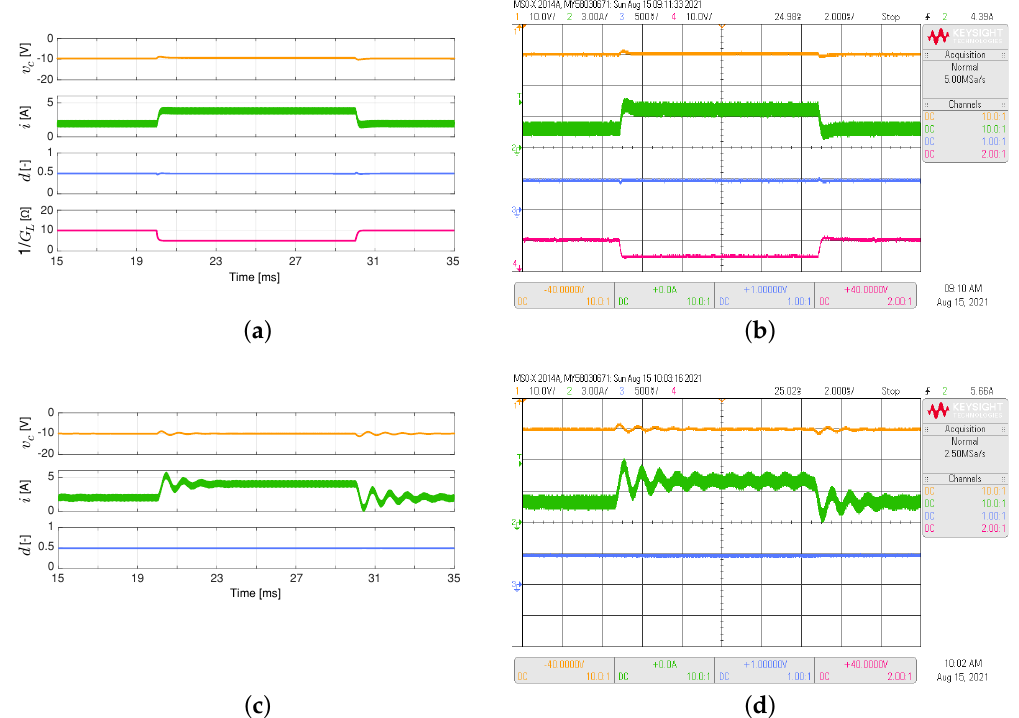
Figure 6. Simulated ( a , c ) and experimental ( b , d ) dynamic responses of the buck-boost converter when the load resistance is a 50 Hz square waveform between 5 Ω and 10 Ω , and a duty cycle of 0.5: ( a , b ) adaptive PI-PBC controller, ( c , d ) PI controller. CH1: v c (20 V/div), CH2: i (3 A/div), CH3: d (500 mV/div), CH4: 1/ G L ( 10 V/div) (it is calculated only by the PI-PBC controller), and time base of